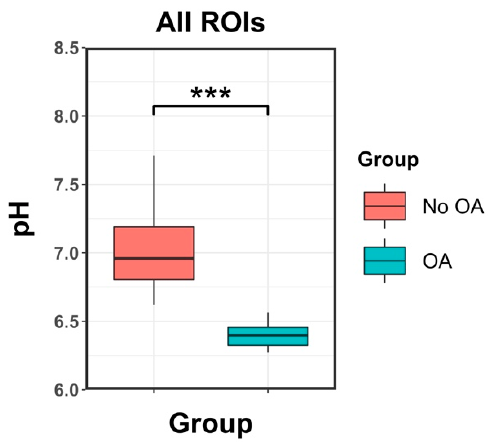
Figure 2. Boxplots of mean pH measurements versus groups for all ROIs. Significant differences are observed between the two groups. ***: p values lower than 0.001.